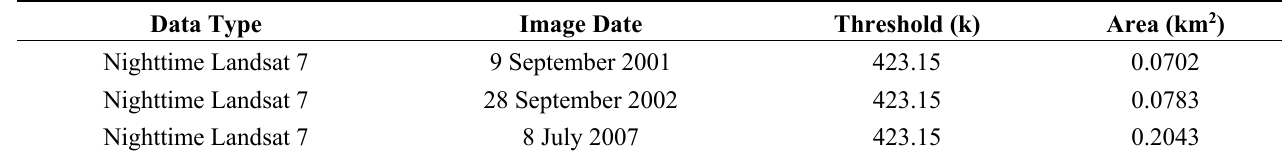
Table 4. Surface coal fires extracted from ETM+ short wave infrared (SWIR) band 7 data.